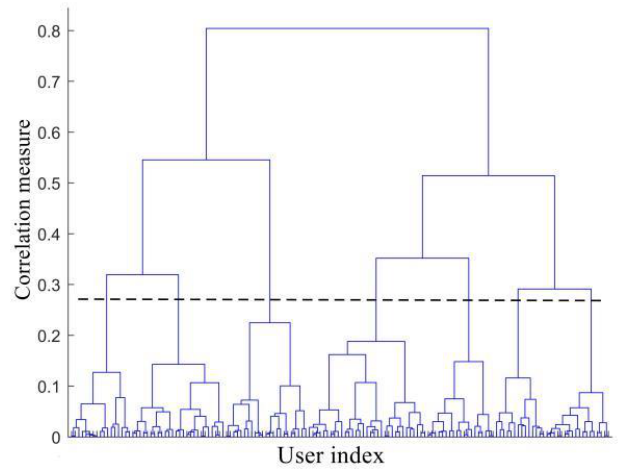
Figure 4. Schematic diagram of the hierarchical clustering algorithm.